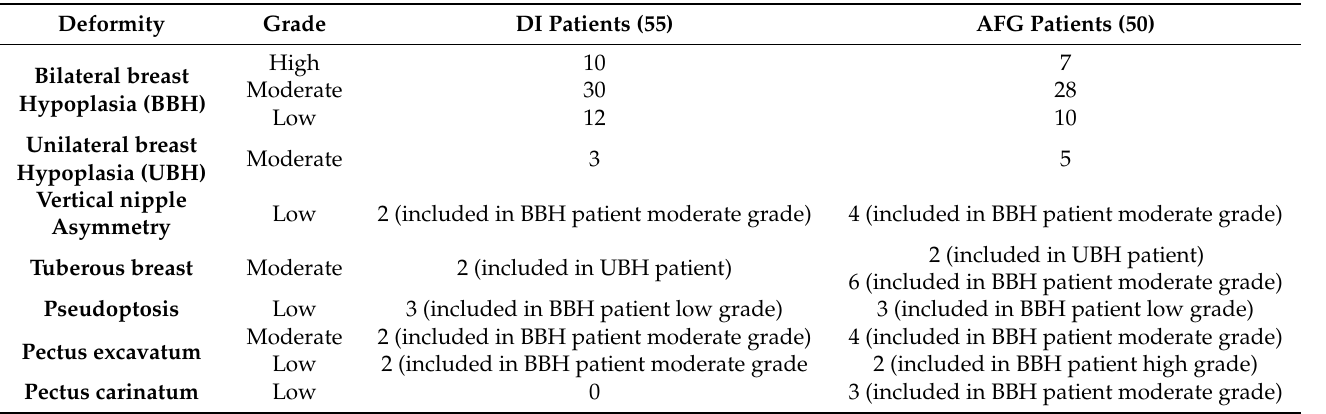
Table 2. Breast and chest deformities.